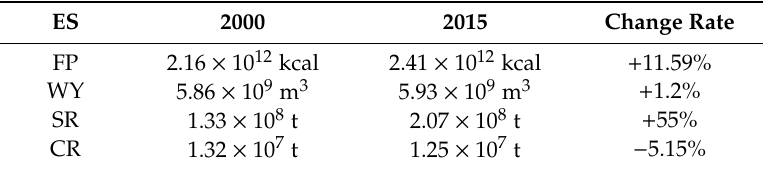
Table A1. The supply amount and changes of four ES from 2000 to